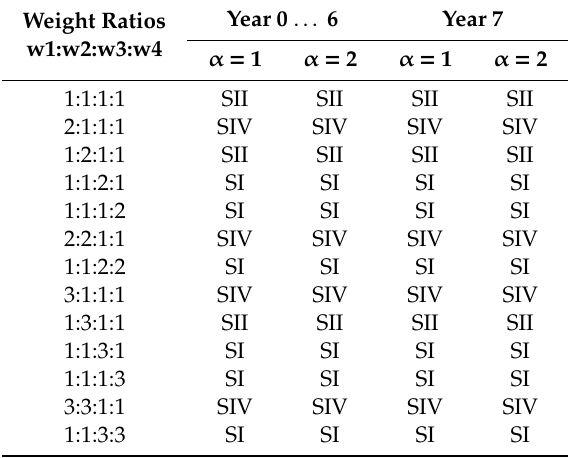
Table 5. Results of the multi-criteria analysis of load distribution taking into account a decrease in the performance of the electrolyzer alone, in the time of